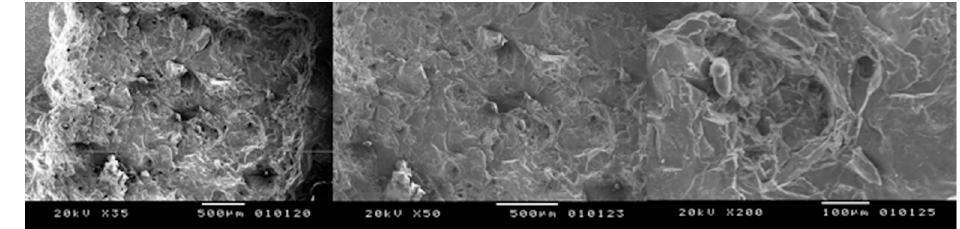
Figure 3. Peak power of 10 kW, speed of 10 mm/s: many zones with melting and carbonization are shown ( left ) X35; ( centre ) X200; ( right ) X500.